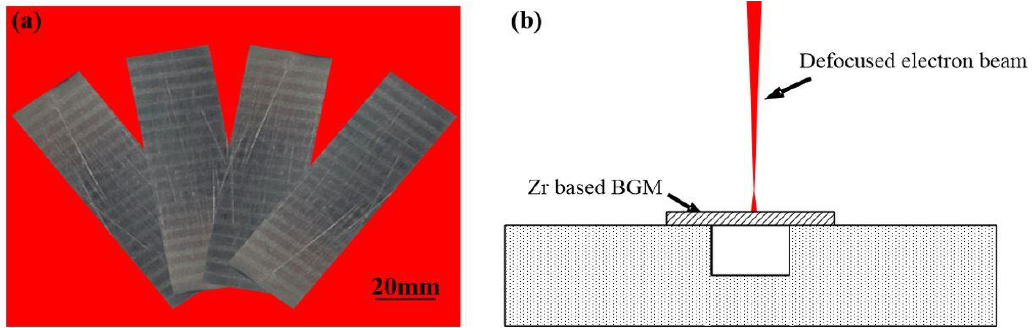
Figure 1. ( a ) The Zr 41.2 Ti 13.8 Cu 12.5 Ni 10 Be 22.5 plate used in the trail and ( b ) the schematic diagram of the remelting process.